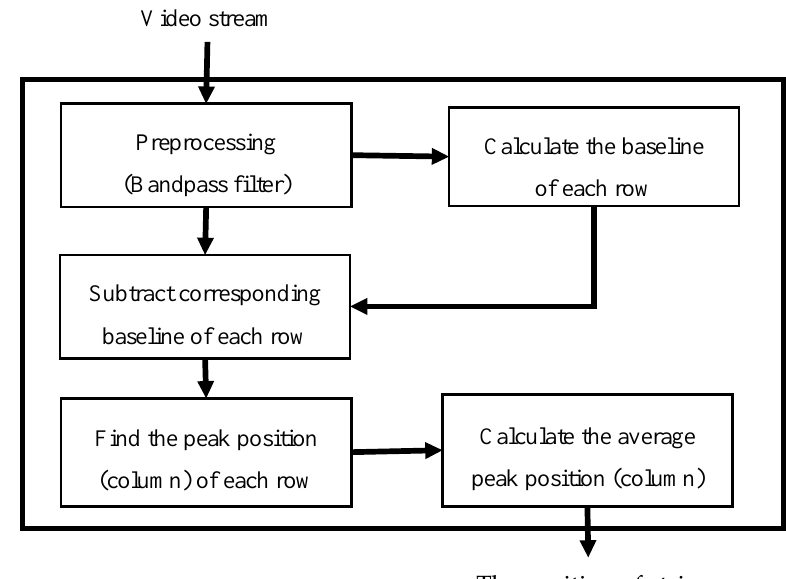
Figure 6. Flow chart for estimating the position of the stripe. In the algorithm, the input video frame is first preprocessed by a bandpass filter to eliminate baseline drift, and then the baseline of each row is calculated. Next, subtract the baseline of each row for the filtered image. Subsequently, find the peak value and corresponding position (column) for every row. Finally, calculate the average position (column) based on the peak position of individual rows.